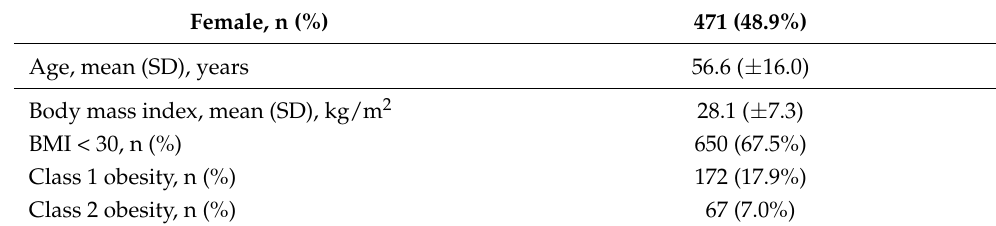
Table 1. Baseline demographic and clinical characteristics of included patients (n = 963).